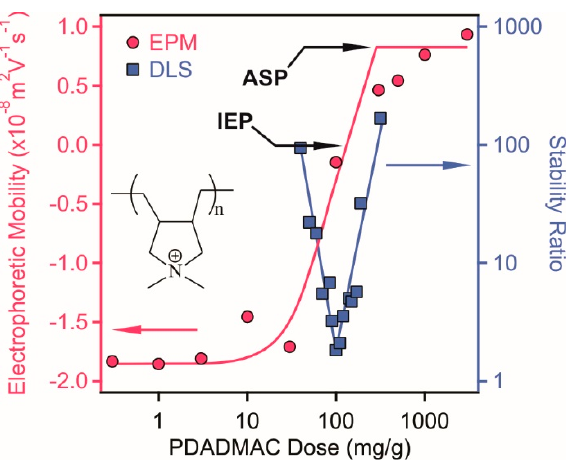
Figure 4. Electrophoretic mobilities (red circles, left axis) and stability ratios (blue squares, right axis) of LDH-PSS (100 mg PSS per one gram of LDH, which corresponds to the dose of the onset of the adsorption saturation plateau (ASP)) as a function of the poly(diallyldimethyl ammonium chloride) (PDADMAC) concentration. The measurements were performed at 10 mg/L particle concentration and 10 mM ionic strength adjusted by NaCl. The structure of PDADMAC is shown in the inset.